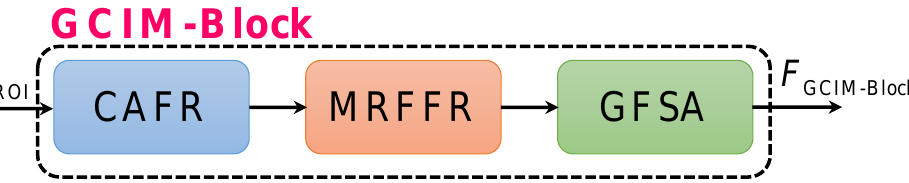
Figure 3. Workflow of the global context information modeling block (GCIM-Block). Here, CAFR denotes the content-aware feature reassembly. MRFFR denotes the multi receptive-field feature response. GFSA denotes the global feature self-attention.